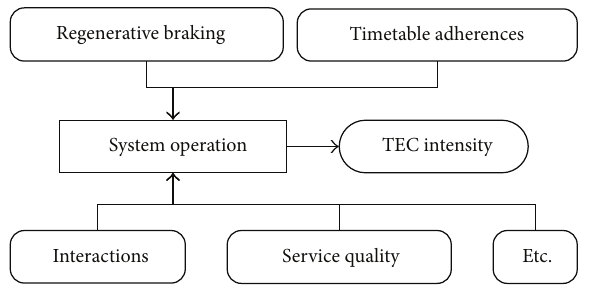
Figure 5: Rationally systematic operation for TEC